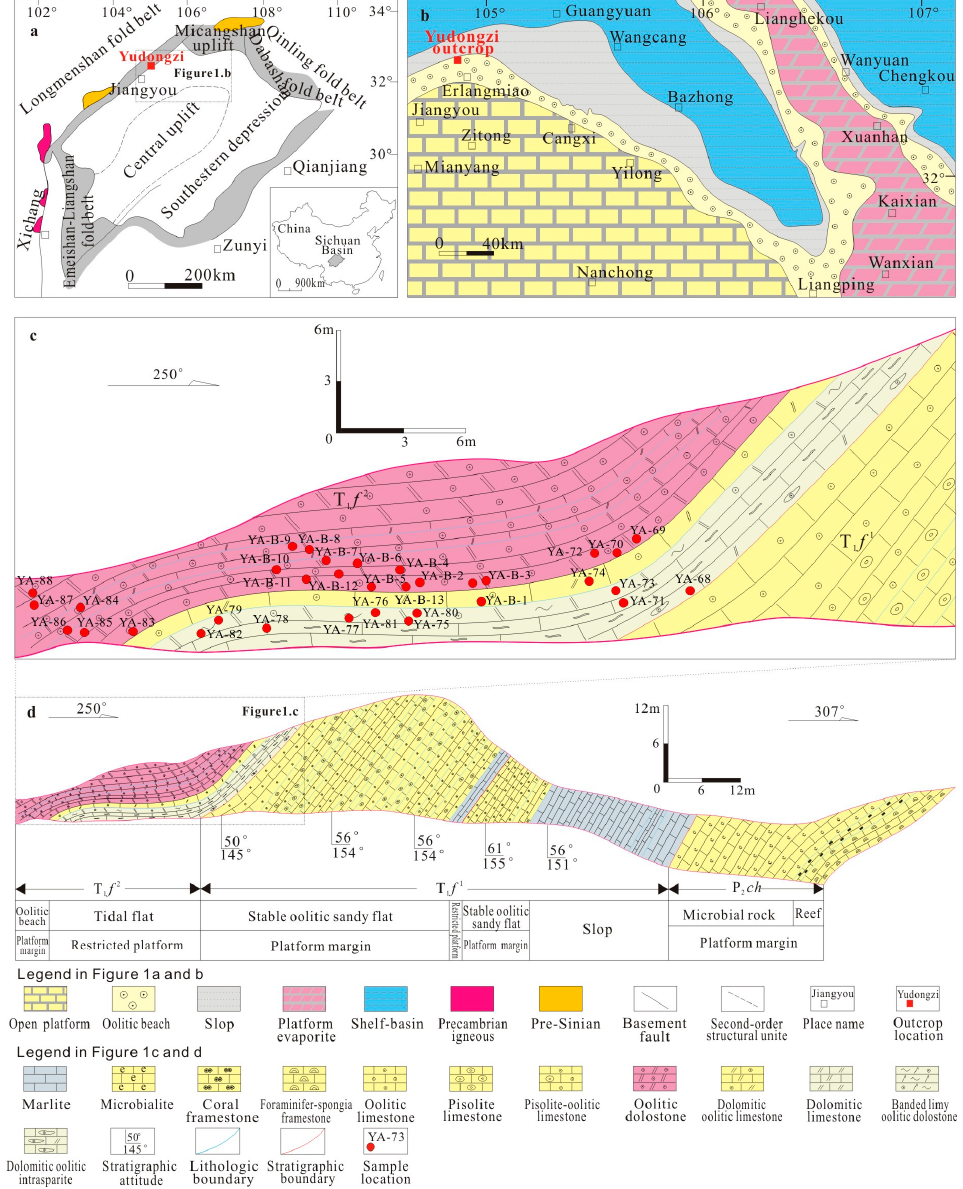
Figure 1. Sedimentary facies and sampling location of the Yudongzi outcrop in the Lower Triassic Feixianguan Formation (modified from Rong, H. et al., 2012 [49]).